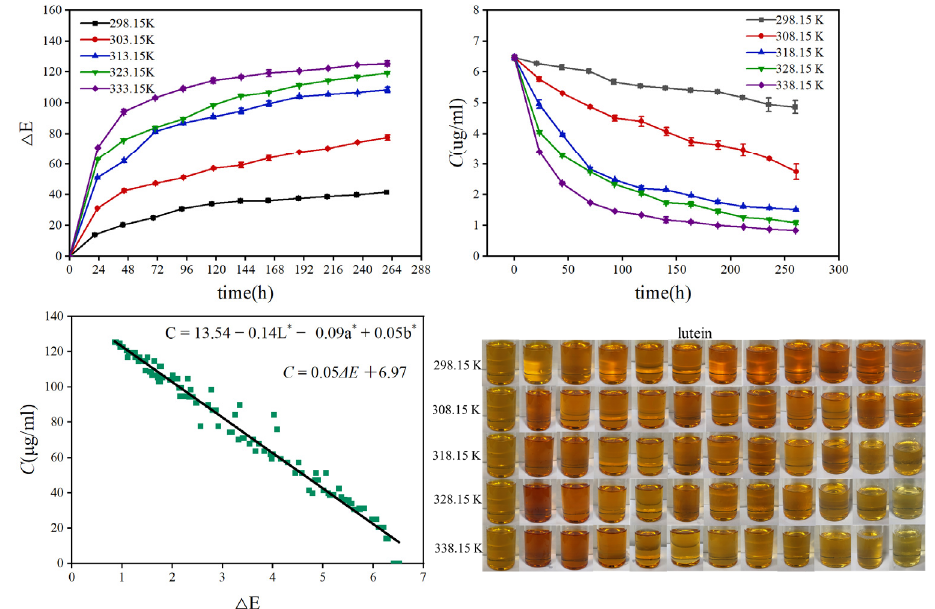
Figure 4. Changes in ∆ E (total color deviation) and concentration ( C ) of lutein with time, the relationship between ∆ E and lutein concentration, and pictures of the [P 4448 ]Cl aqueous solution ( w water = 20%) containing lutein during storage for 12 days at 298.15–338.15 K.